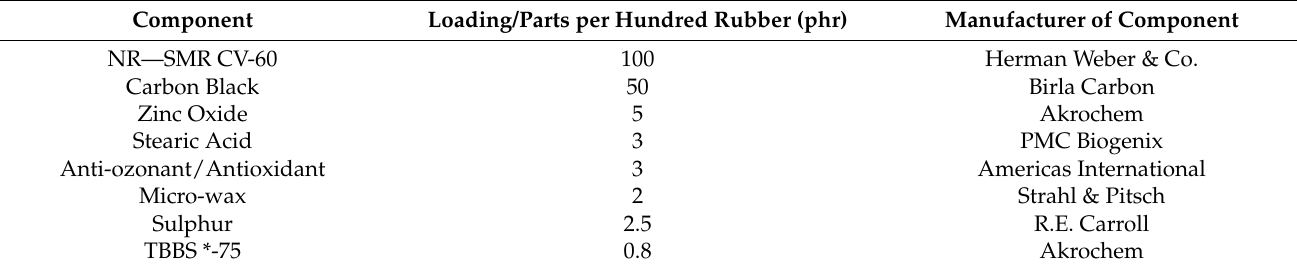
Table 1. Compound formulation.